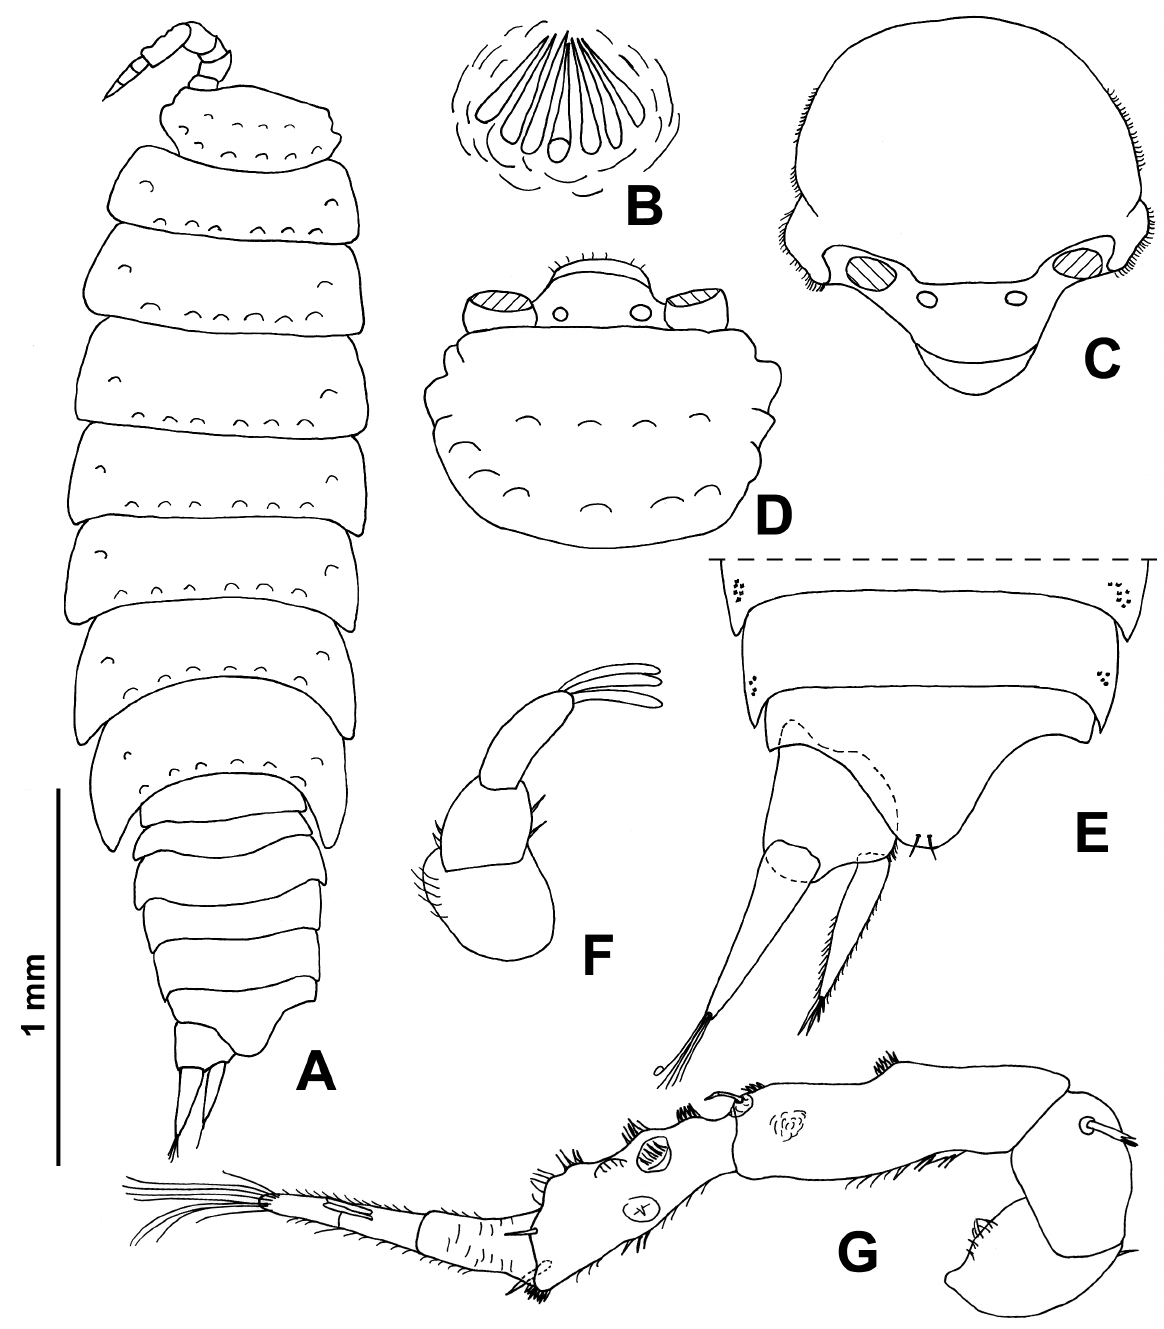
Fig. 16. Troglonethes arrabidaensis Reboleira & Taiti sp. nov. from Gruta do Frade, Arrábida. — Paratype, ♀. A . Adult specimen in dorsal view. B . Dorsal scale-seta. C . Cephalon in frontal view. D . Cephalon in dorsal view. E . Pleonites 4, 5, telson and left uropod. — Paratype, ♂. F . Antennula. G .